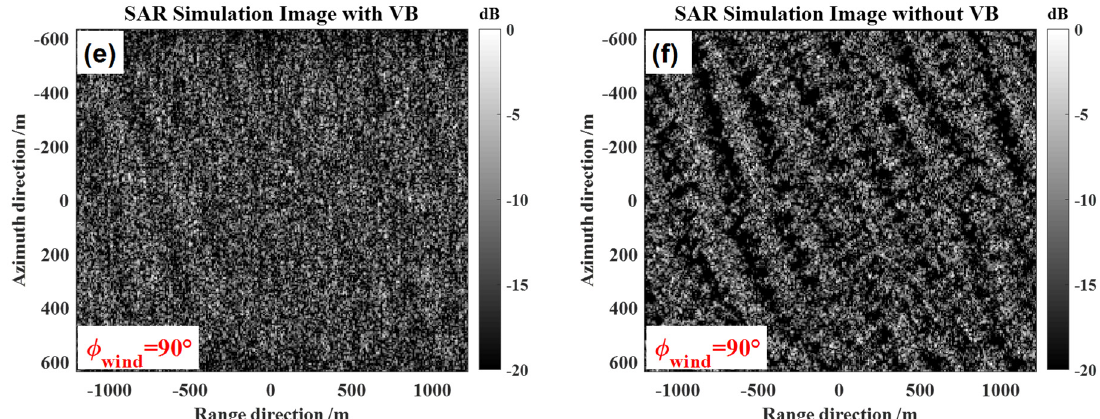
Figure 10. The SAR simulation images with the VB effect at different wind direction: ( a ) φ wind = 0 ◦ , ( c ) φ wind = 45 ◦ , and ( e ) φ wind = 90 ◦ ; without the VB effect at different wind direction: ( b ) φ wind = 0 ◦ , ( d ) φ wind = 45 ◦ , and ( f ) φ wind = 90 ◦ .